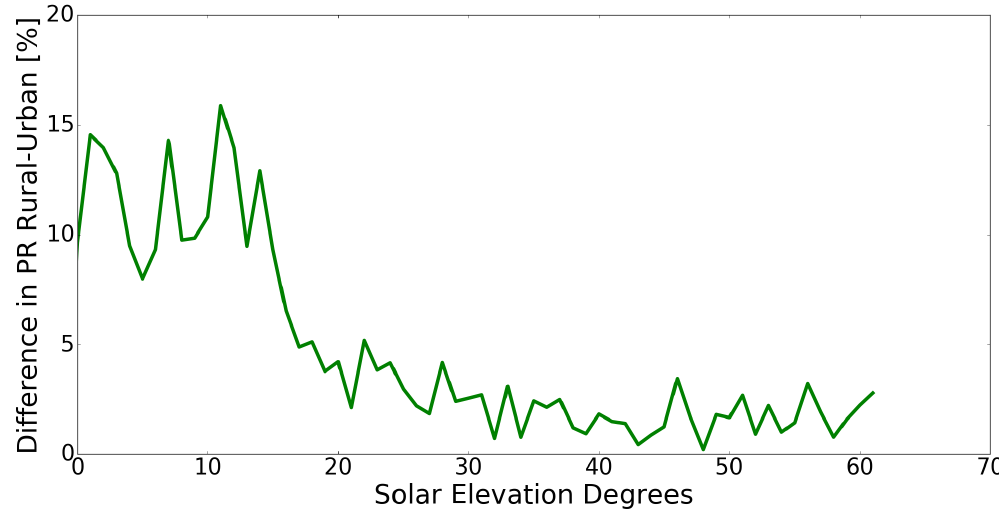
Figure 7. Difference in PR between PV installations in rural and urban areas versus the solar